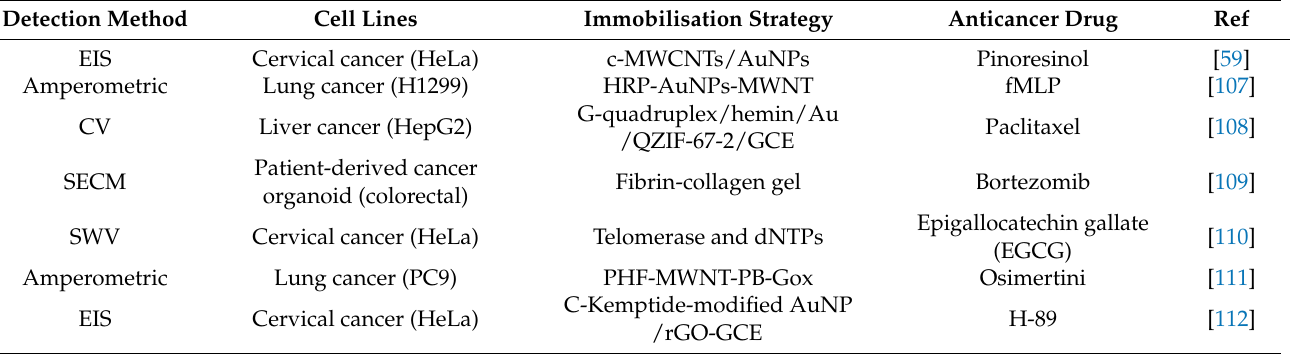
Table 2. Electrochemical biosensing platforms for anticancer drug testing.